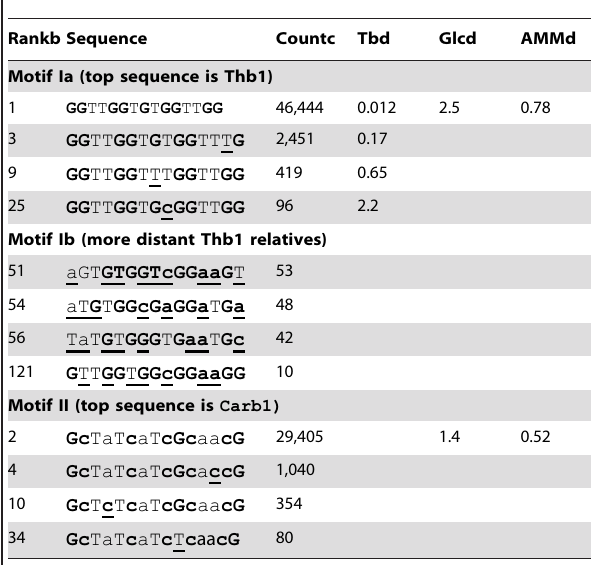
a. See Table 2 for counting statistics. Four sequences from each motif are shown: underlined bases in motifs I and II differ from the top candidate; bold fonts and capitals are used to highlight motif similarities. b. Order of abundance in the deep sequencing results. c. Counts for indicated sequence. d. K d values (in m M) measured by SPR for Tb=Thrombin, Glc=glucose, AMM= a -methyl mannoside (accuracy estimated at 6 30%). K d values for blank cells were not